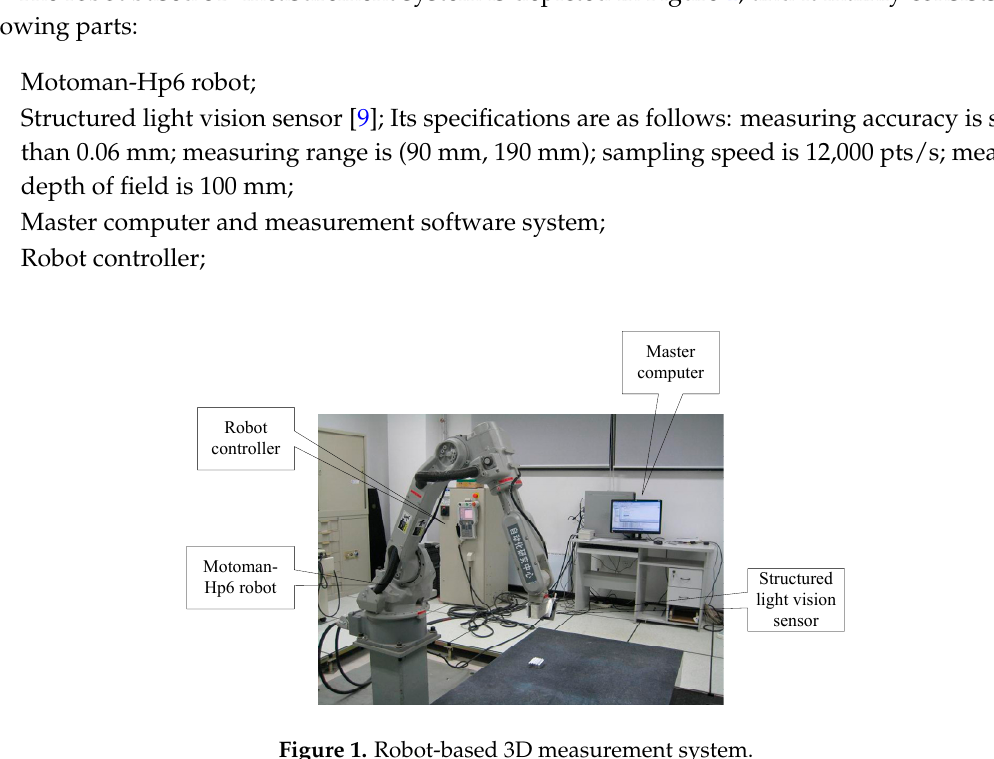
Figure 1. Robot-based 3D measurement system.